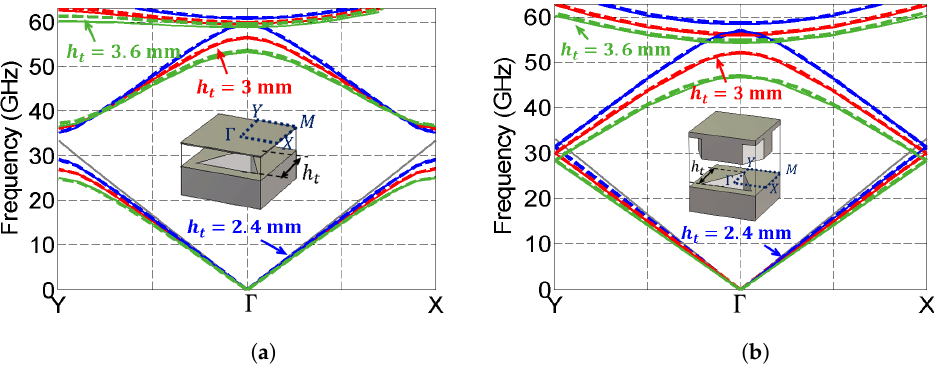
Figure 4. Dispersion diagram of the ( a ) mirror-symmetric and ( b ) glide-symmetric unit cells when varying the height of the triangle. Dashed lines represent the results extracted from CST and solid lines the results extracted from the mode-matching. The light line is displayed in gray. The geometrical parameters of the unit cells are: h hole = 1.5mm, g = 0.5mm, and d x = d y = 4.5mm.